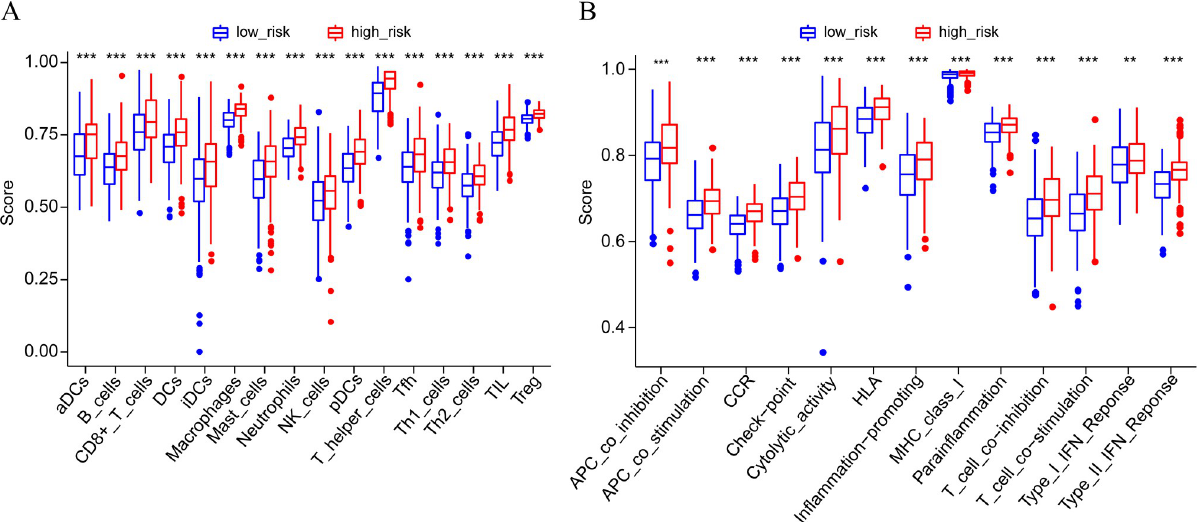
Fig 13. Comparison of the ssGSEA scores between different risk groups in the TCGA cohort. The scores of 16 immune cells (A) and 13 immune- related functions (B) are displayed in boxplots. CCR, cytokine-cytokine receptor. Adjusted P values were showed as: ns, not significant; � , (P < 0.05; �� , P < 0.01; ��� , P <